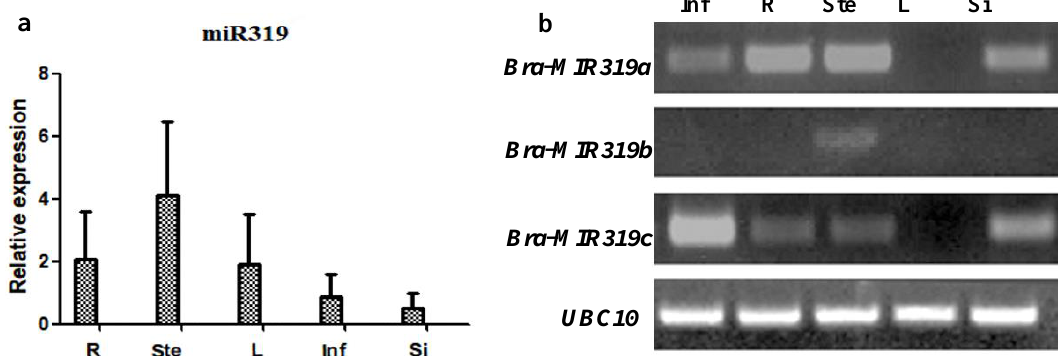
Figure 1. Expression pattern of Bra-miR319 family members. ( a ) Quantitative real-time PCR analysis of Bra-miR319 in different tissues of Brassica campestris . ( b ) Real-time PCR analysis of precursor genes of Bra-miR319 in different tissues of B. campestris . Roots (R), stems (Ste), leaves (L), inflorescences (Inf), and siliques (Si).